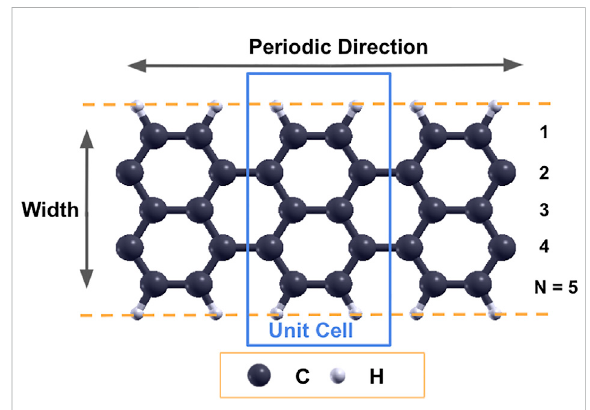
FIGURE 1 Schematic of a 5-AGNR. Dashed lines represent the edges of graphene nanoribbons, and the blue rectangle represents the unit cell used in